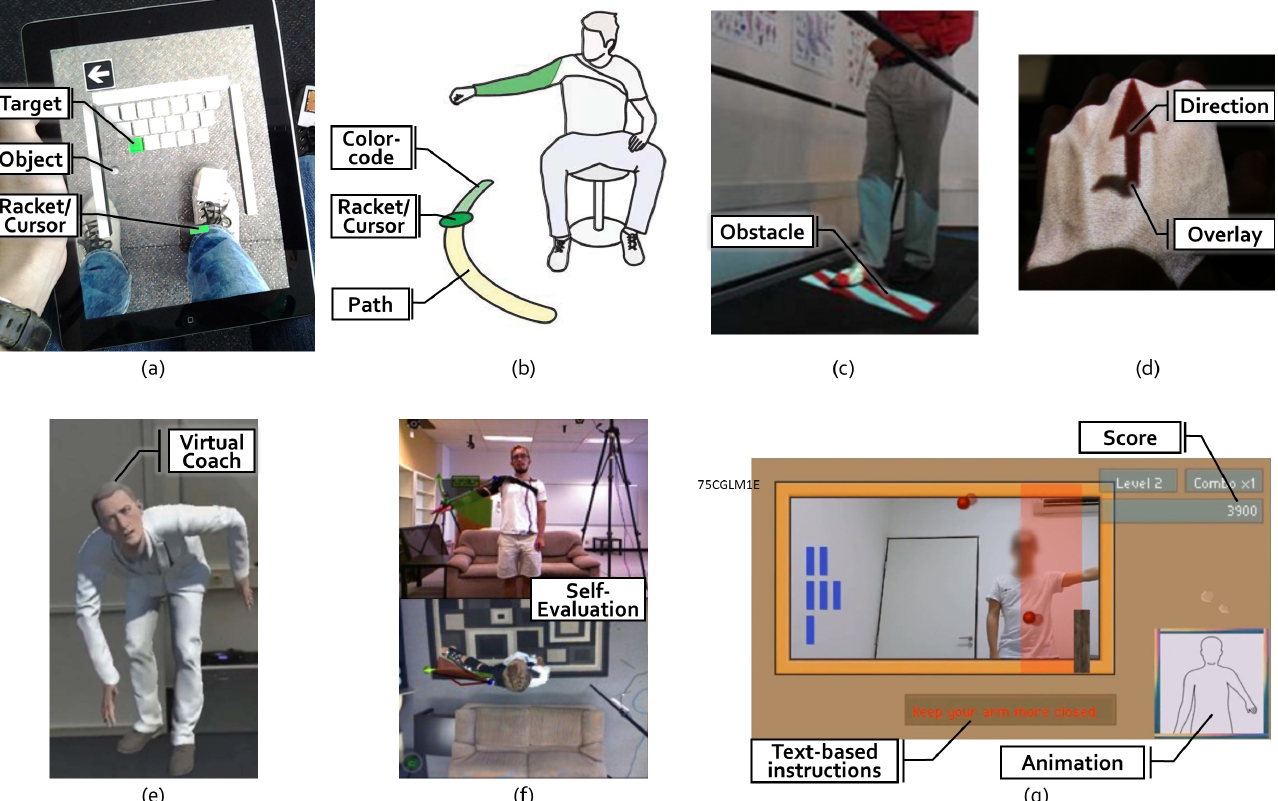
Figure 3. Illustrative examples of visual guidance within the selected references: ( a ) game-based ankle exercise using a racket to direct an object into a target [13]; ( b ) task-based elbow and shoulder exercise guiding the patient’s cursor along with a color-coded path [12]; ( c ) task-based gait training on treadmill displaying an obstacle to be avoided by the patient [35]; ( d ) arrow overlay projected onto the patient’s hand guiding him in the right direction [30]; ( e ) virtual coach demonstrates the correct performance of an exercise [37]; ( f ) alternative angle displayed on the screen in front of the patient allows him to evaluate his movements [28]; ( g ) game screen extended with text-based instructions, score, and animation demonstrating the correct performance of the exercise